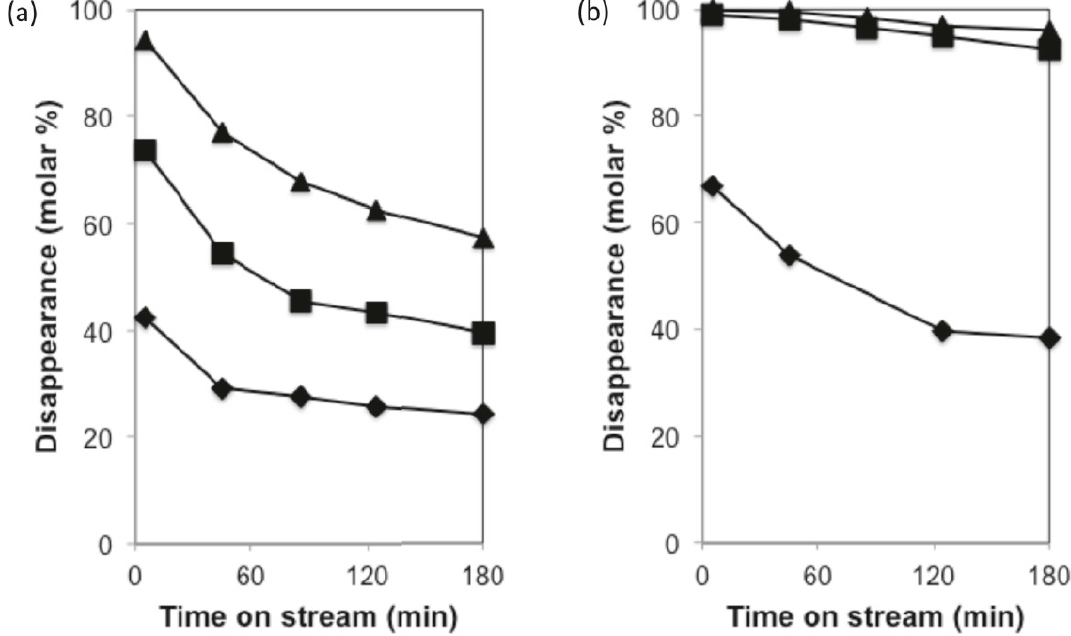
Figure 19. Continuous hydrodeoxygenation of ( a ) anisole and ( b ) guaiacol at 400 °C under atmospheric pressure over Pt ‐ Sn/CNF/Inconel catalyst [48].